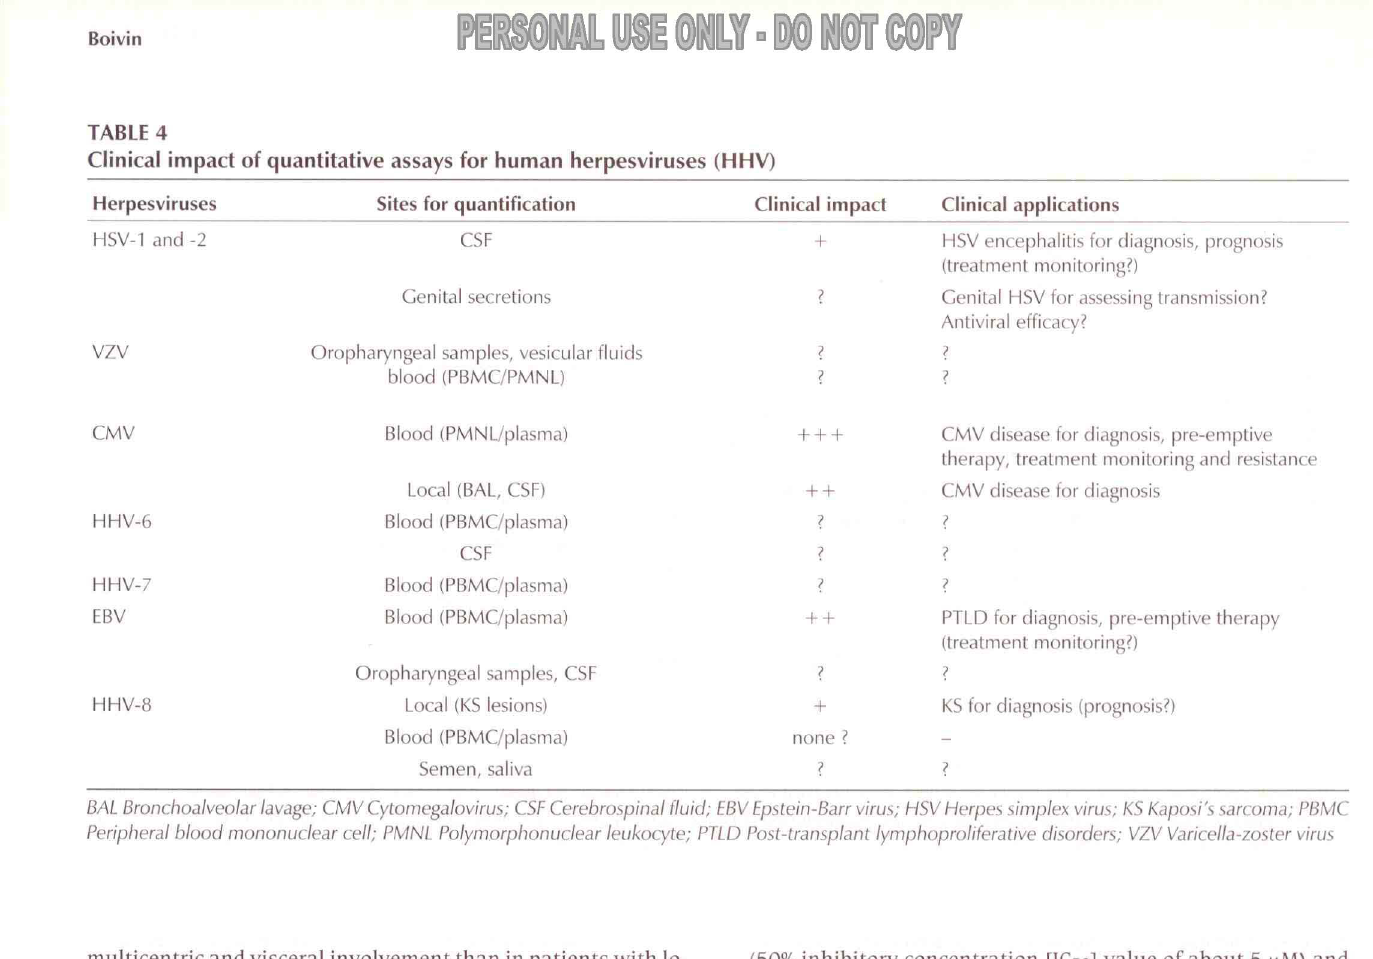
Clinical impact of quantitative assays for human herpesviruses (HHV) Herpesviruses Clinical impact Clinical